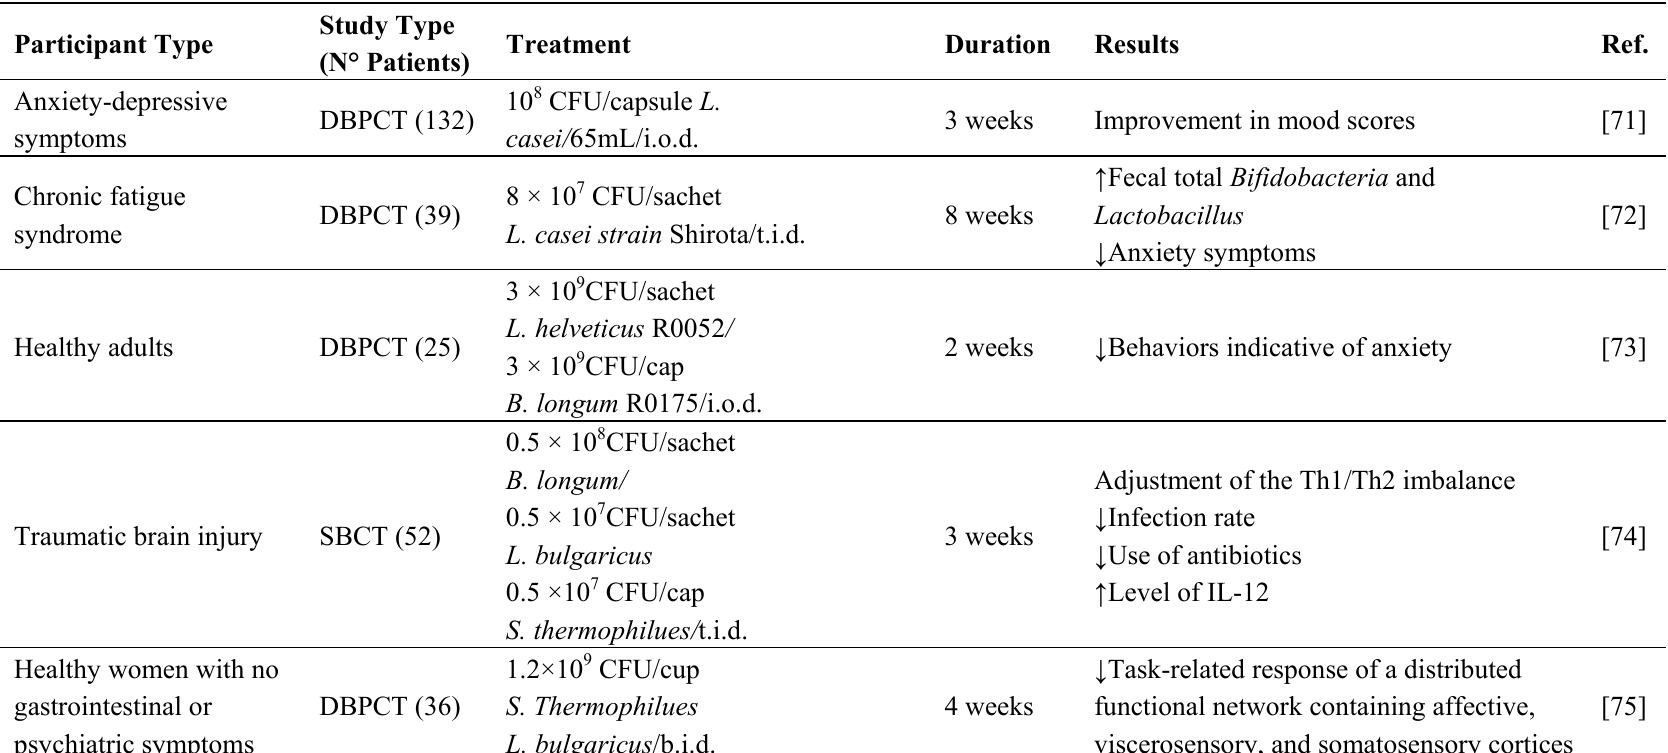
Table 4. Clinical studies of probiotics and brain